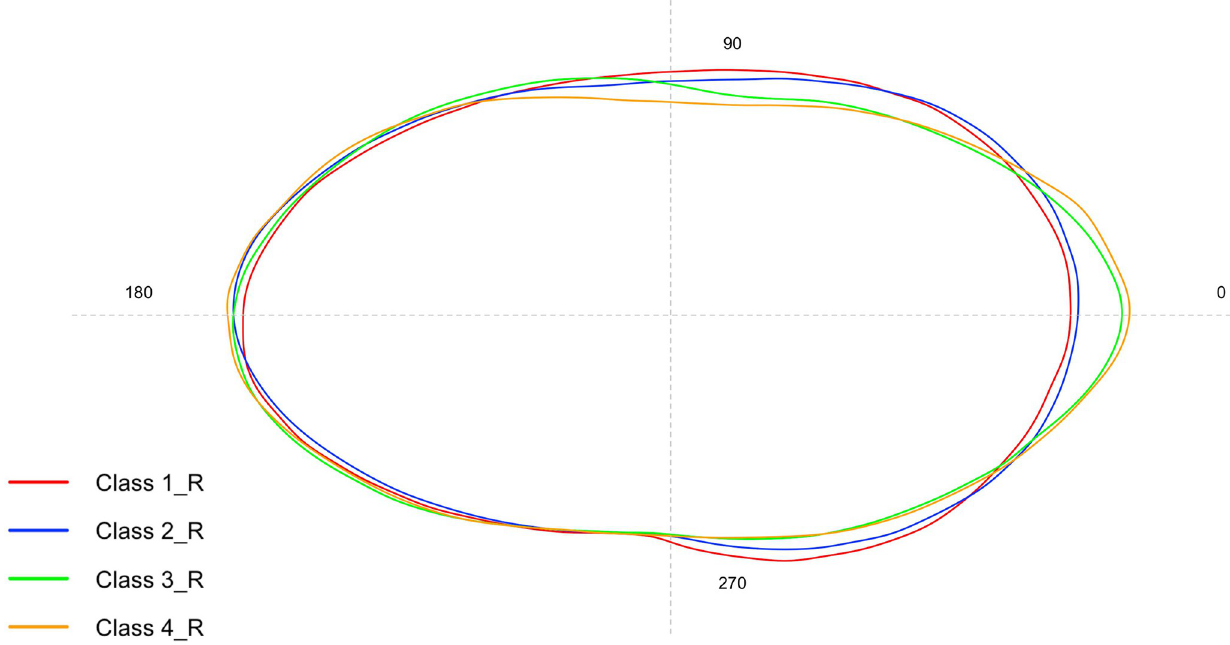
Fig 3. Mean shape of right sagittae contours belonging to the four investigated size